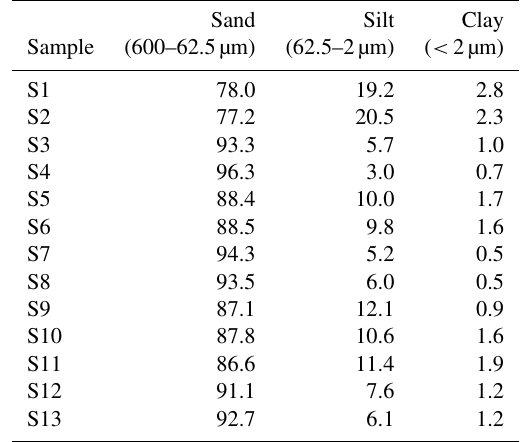
Table 2. The volume particle size fraction (%) of the < 600µm sieved soil